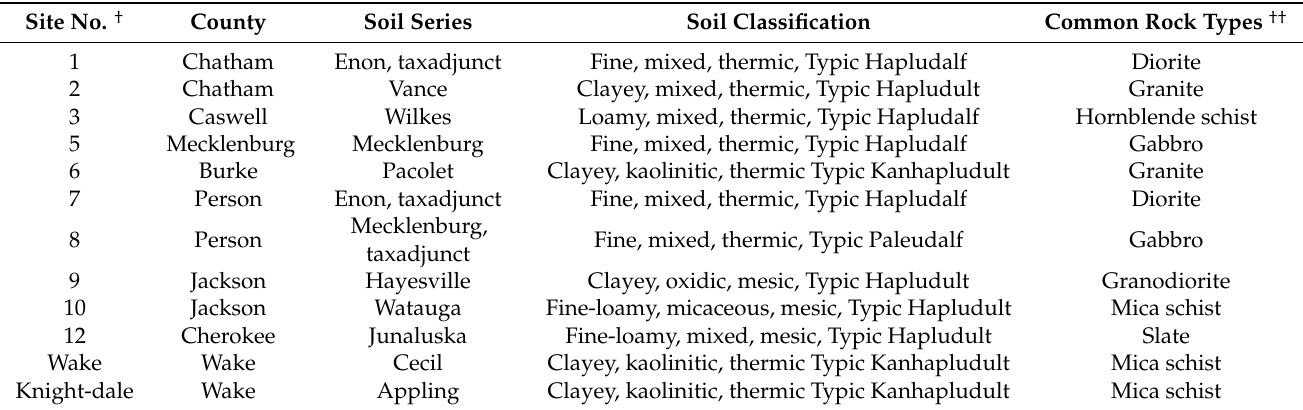
Table 1. Site number, county location, soil series, soil classification, and common parent rock type for the saprolite at the 12 sites in the Piedmont and Mountain Regions of North Carolina. Site numbers and names are those used by